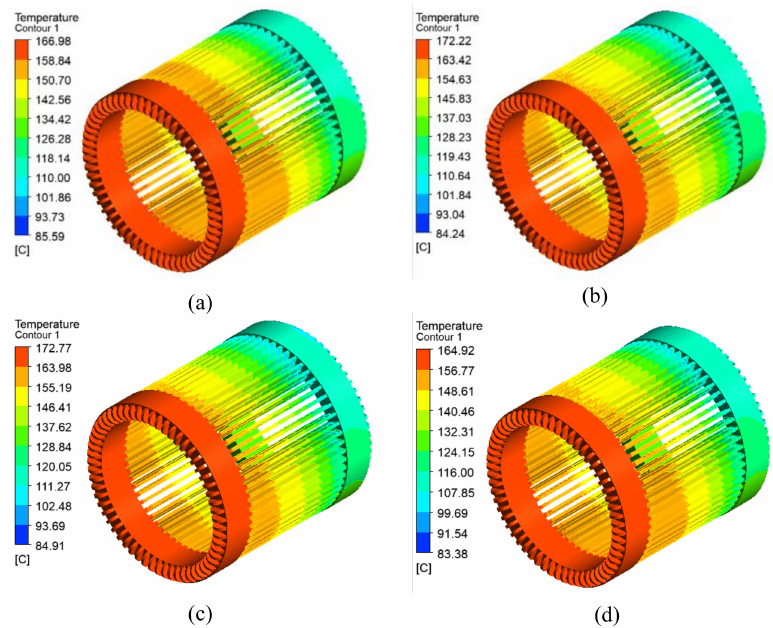
Figure 17. Temperature comparison of the stator winding under schemes with varying radial